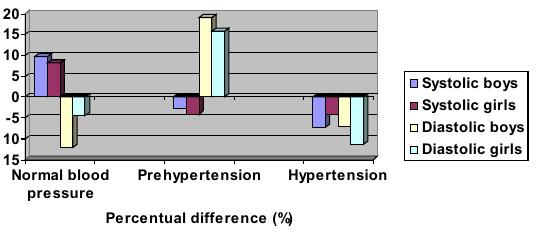
Figure 3 Evaluation of blood pressure in children age between 10 and 20